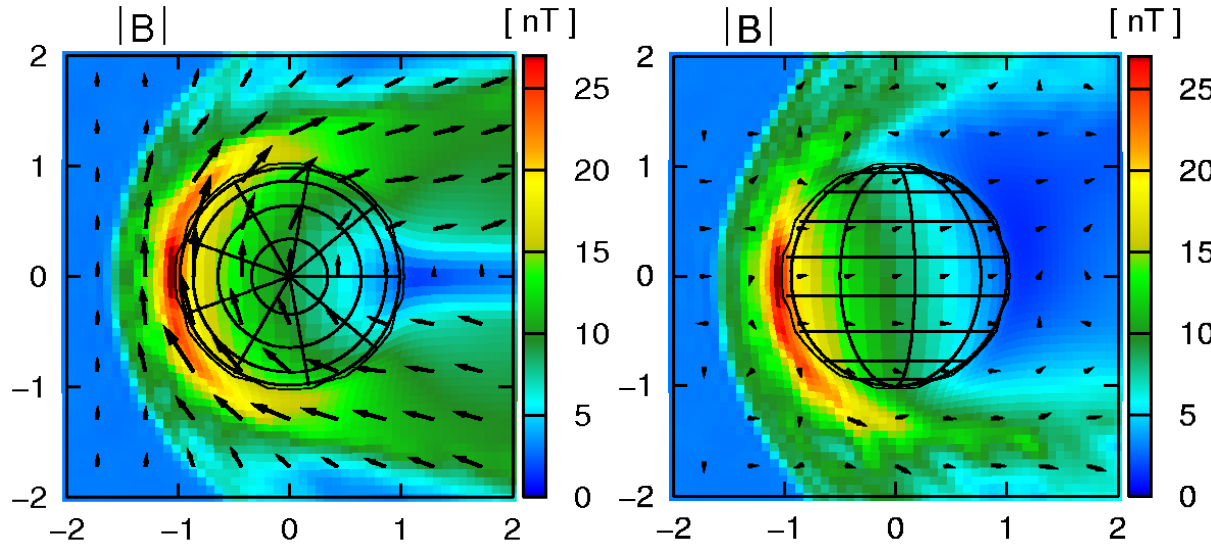
Fig. 4. Hybrid simulation: Distribution of the magnetic field strength in the xy plane (left) and xz plane